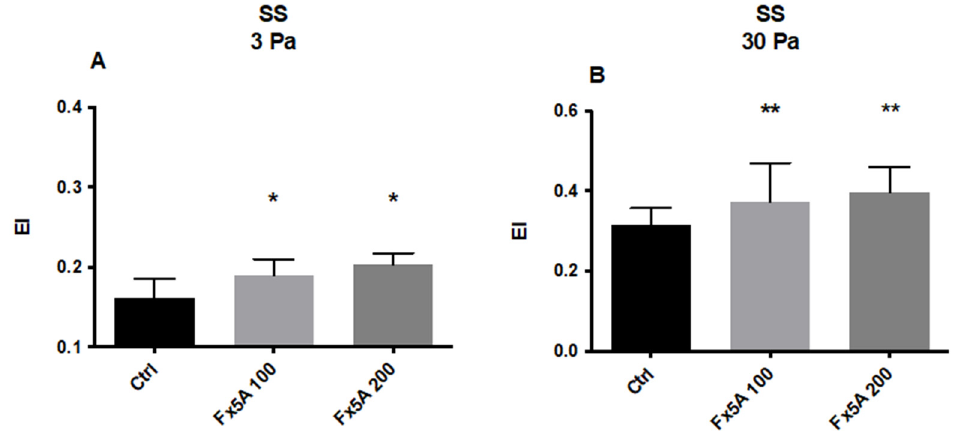
Figure 3. Deformability of RBC from HbSS at 3 ( A ) and 30 Pa ( B ) after incubation with Fx5A (100 µ g/mL and 200 µ g/mL) (n = 9). *, p < 0.05; **, p < 0.01. EI: Elongation Index.